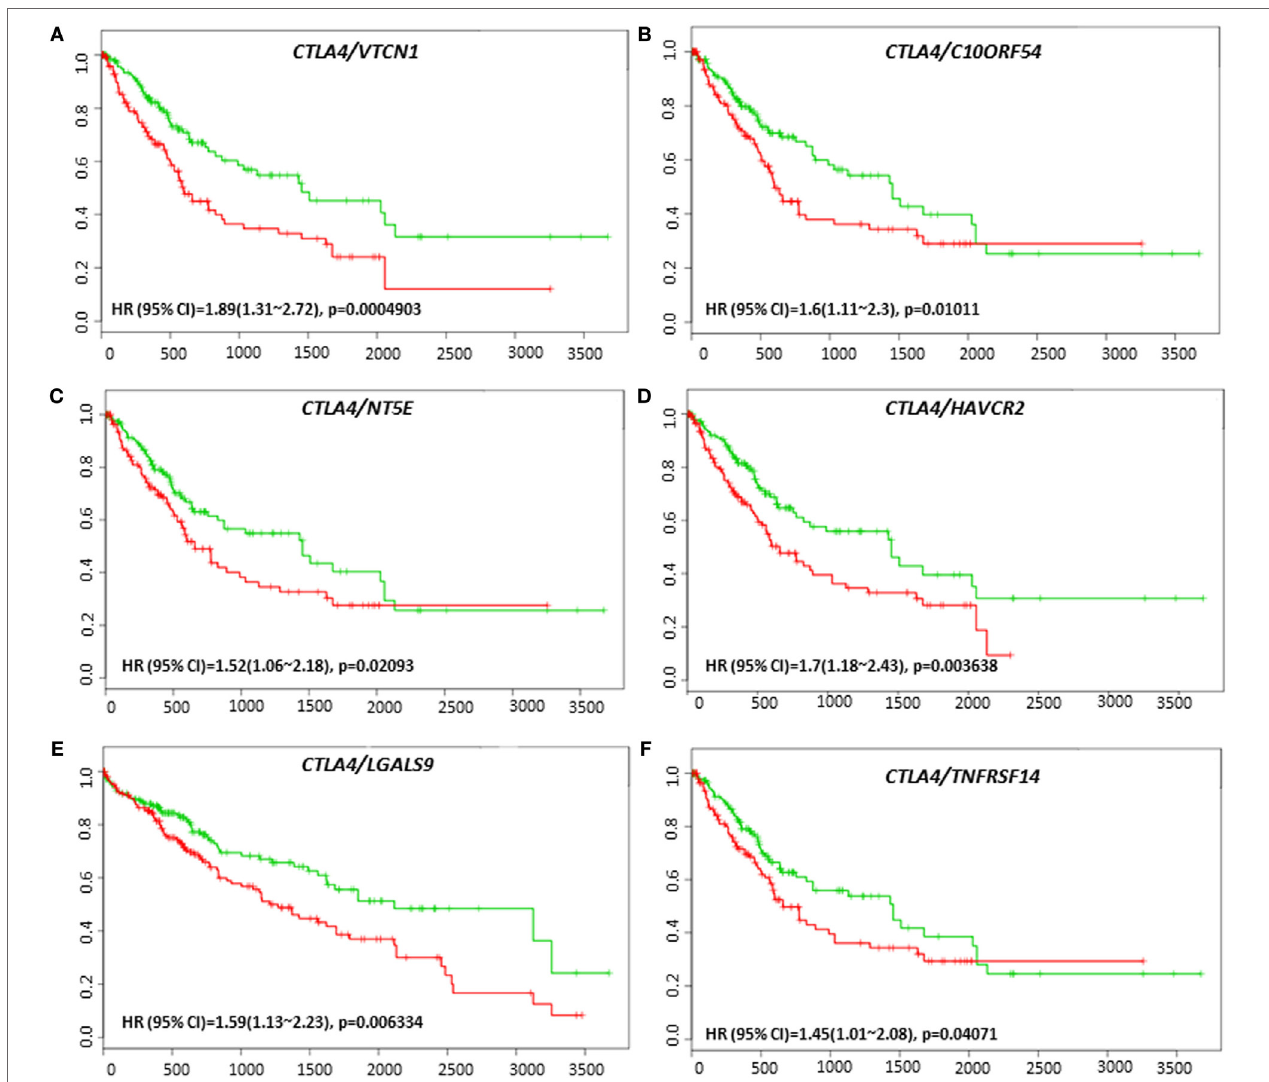
FigUre 10 | Relationship of immune modulators in combination with CTLA-4 and recurrence-free survival in HCC patients. Kaplan–Meier curves produced using the SurvExpress for the analysis of recurrence-free survival and gene expression of (a) CTLA-4/VTCN1 , (B) CTLA-4/C10ORF54 , (c) CTLA-4/NT5E , (D) CTLA-4/ HAVCR2 , ( e) CTLA-4/LGALS9 , and (F) CTLA-4/TNFRSF14 in HCC patient samples. Green curve represents low-risk group, while red curve represents high-risk group. The study time (months) is presented on the x -axis. The insert shows the hazard ratio, confidence interval, and Log-Rank Equal Curves p value. Markers ( + ) represent censoring